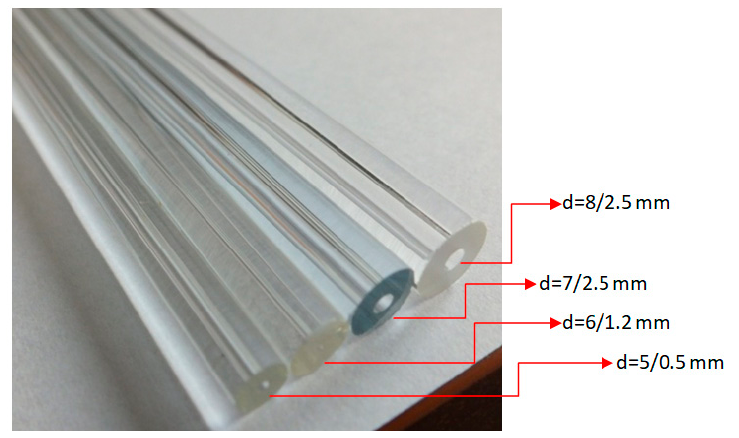
Figure 3. Overview of the used glass minichannels.